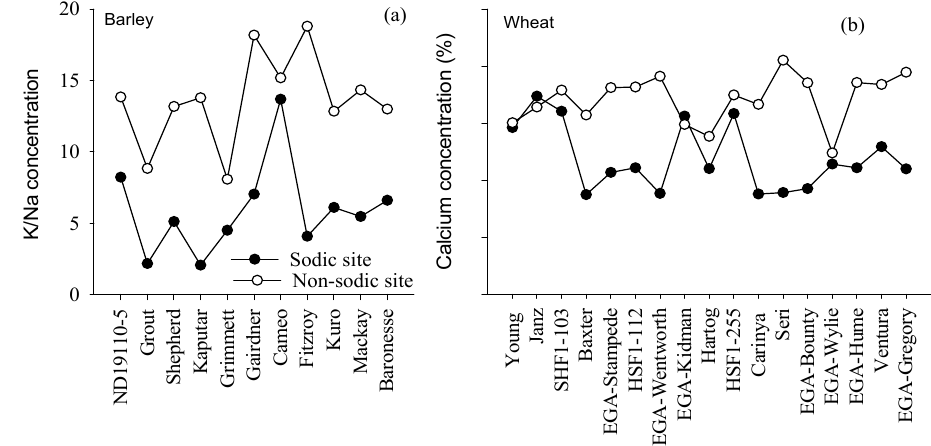
Figure 8. Ranking of ( a ) potassium/sodium concentration in young mature leaves of barley and ( b ) calcium concentration in young mature leaves of wheat genotypes grown on a sodic site and a non ‐ sodic site in 2008 at Goondiwindi in southern Queensland.